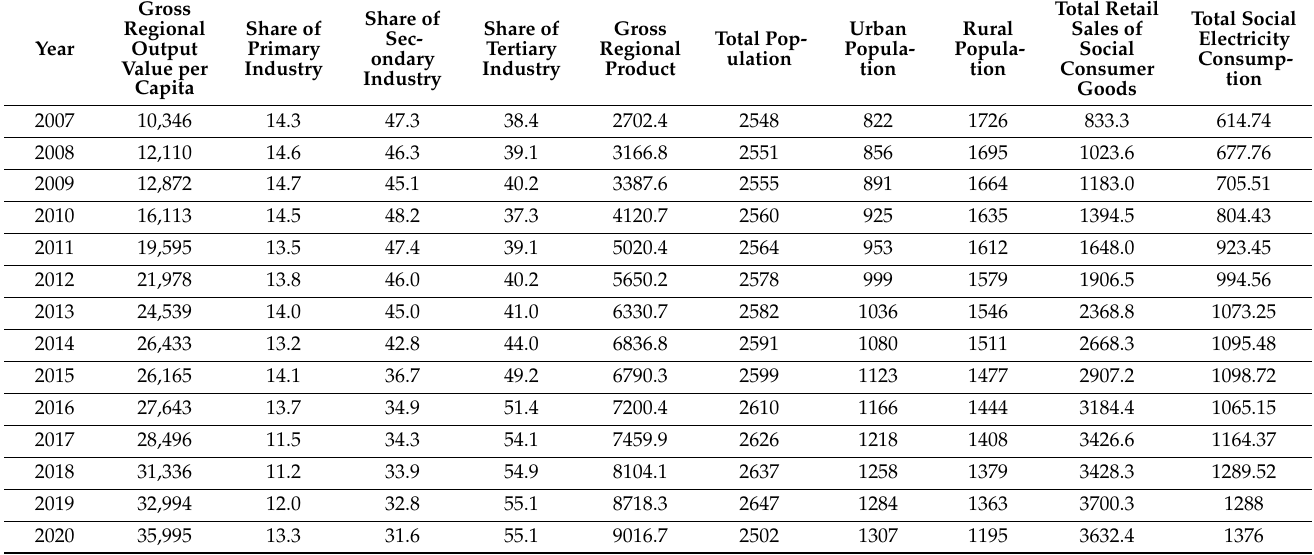
Table 1. Social data.